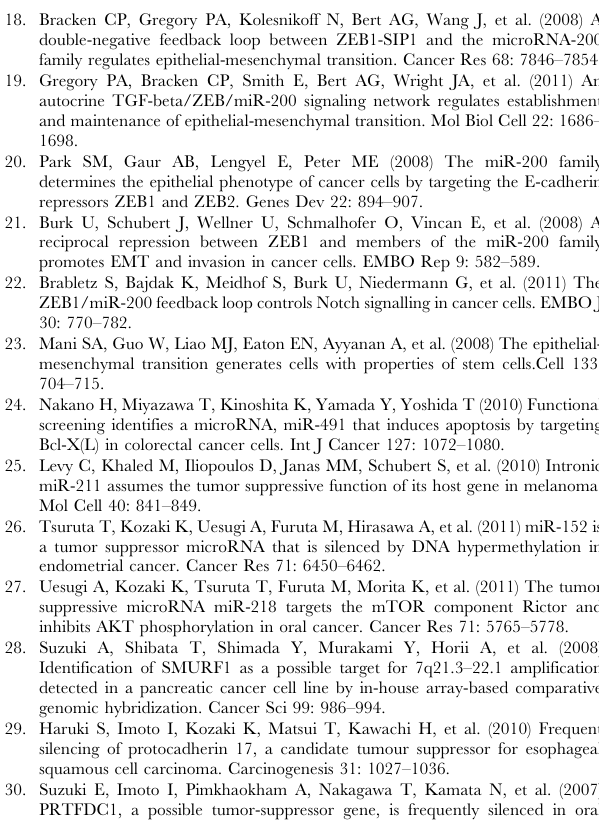
Figure S6 A , The correlations between miR-655 and ZEB1/ TGFBR2 on mRNA levels in ESCC/OSCC primary samples. B , The correlations between miR-655 and ZEB1/TGFBR2 on mRNA and protein levels. The quantification of each protein band in the result of Western blotting was done using LAS-3000 with MultiGauge software (GE Healthcare, Tokyo, Japan). Pearson’s test was performed to determine the degree of correlation between two variables. Figure S7 TaqMan real-time RT-PCR analysis ( Upper ) and Western blot ( Lower ) analysis for ZEB1 ( left ) and TGFBR2 ( right ) in Panc1, KP1N and MDA-MB-231 cells 96 hours after transfection of 10 nM of ds- NC or ds- miR-655 (Thermo Scientific Dharmacon). Figure S8 A , Complementary miR-655 seed sequence and PCR region in the 3 9 UTR of ZEB1 ( Upper ) and TGFBR2 ( Lower ). These sites were analyzed using microRNA.org and Target Scan Human 6.2. B , Results of luciferase reporter assays in Panc1 cells 48 hours after cotransfection of pMIR-REPORT luciferase vectors containing wild-type of ZEB1 or TGFBR2 for miR-655 , ds- miR-655 or ds- NC , and the pRL-CMV internal control vector. Asterisks (*), statistical analysis with the Mann-Whitney U test. Figure S9 TaqMan real-time RT-PCR analysis for CDH1/E- cadherin ( left ) and PAI-1 ( right ) in KP1N cells 96 hours after